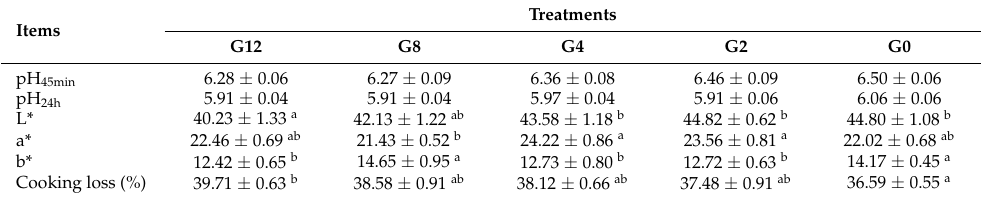
Table 5. PH, meat color, and cooking loss of LT muscle of Tan lambs under different restricted grazing time and indoor supplementary feeding systems.